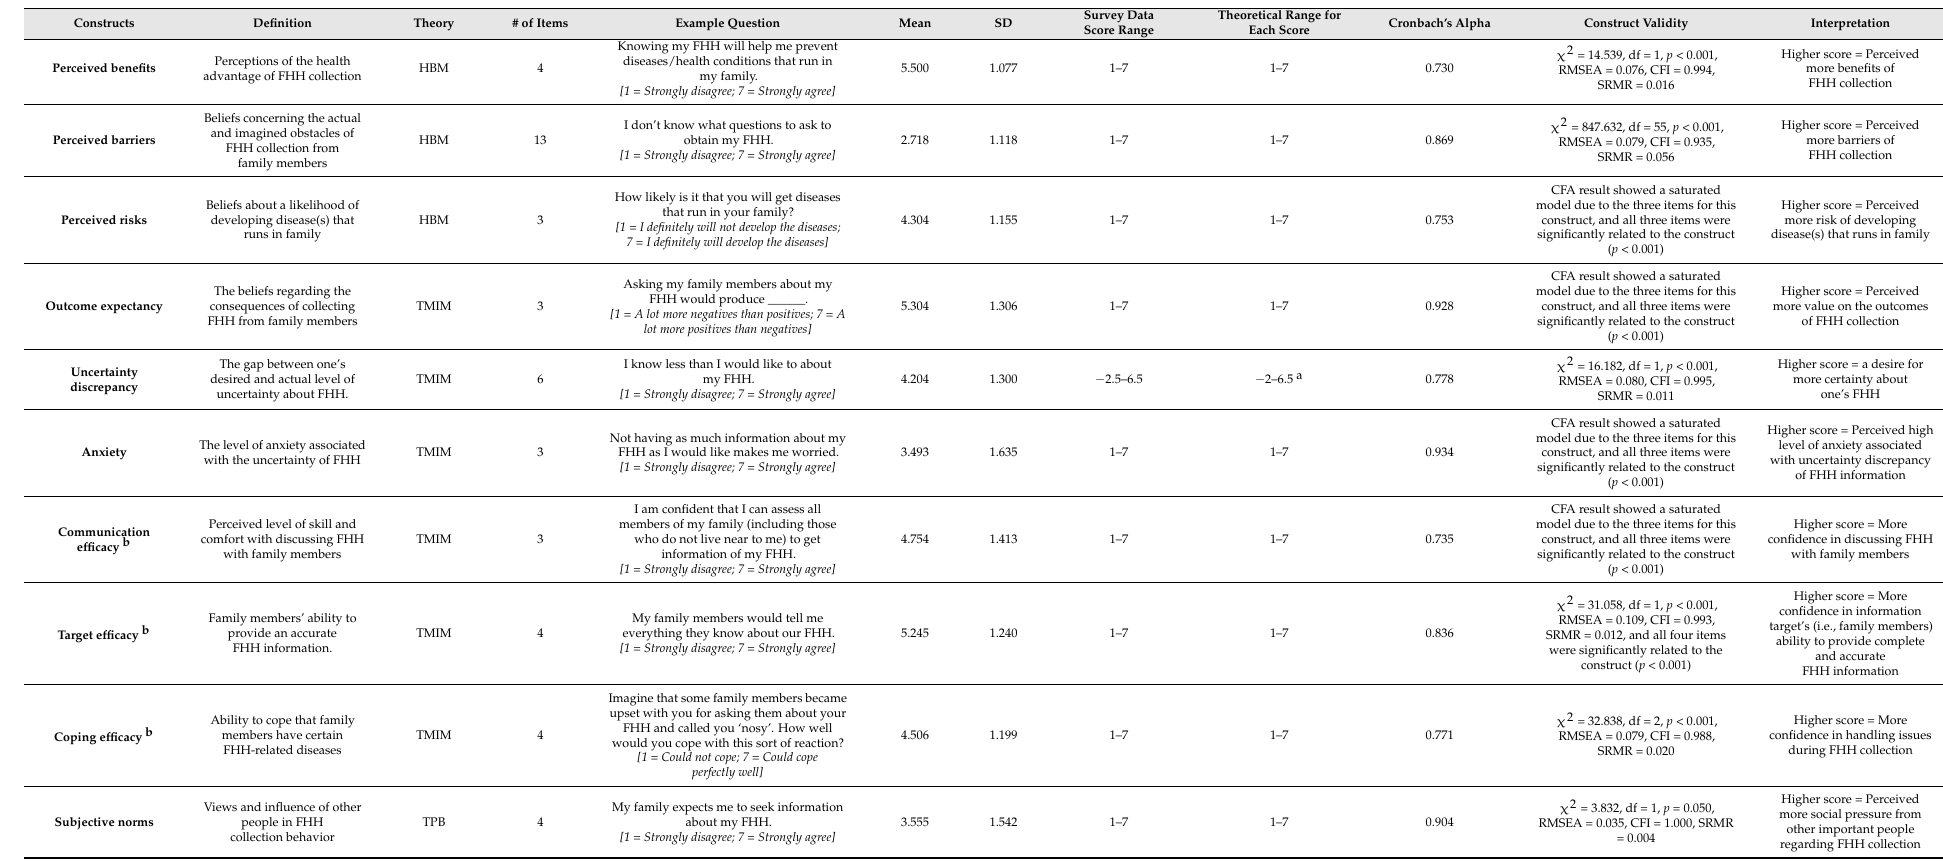
Table 1. Definitions, description, examples, and data reliability and validity of the psychological constructs measured in the